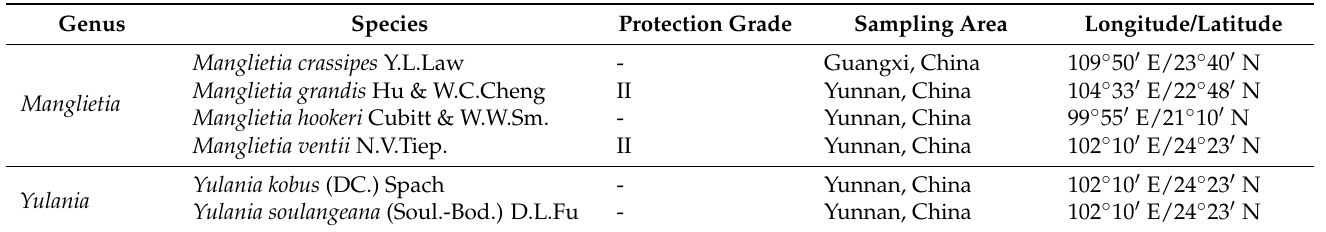
Table 1. The sampling area and information of six species of the Magnoliaceae